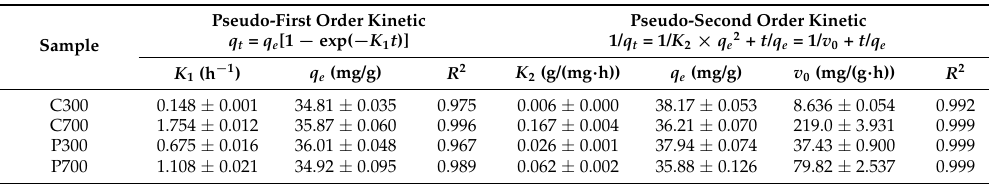
Table 3. Kinetic equation parameters for the adsorption of DBSA on biochars.